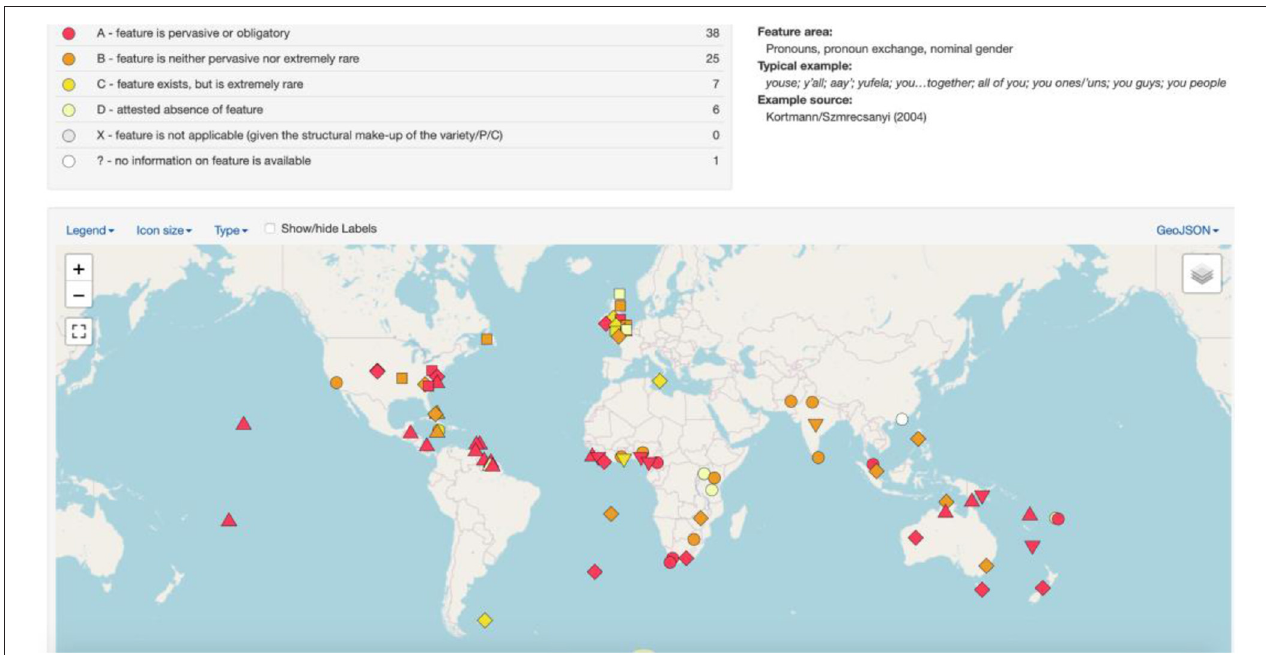
FIGURE 9 | Screenshot of eWAVE Feature 34: “Forms or phrases for the second person plural pronoun other than you ” *from https://ewave-atlas.org/parameters/ 34#2/7.0/7.7.